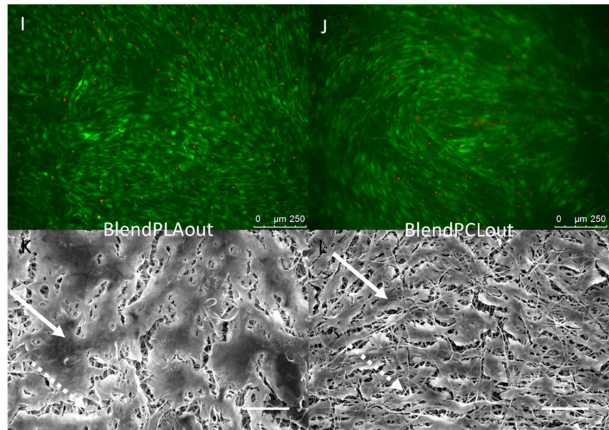
Figure 4. Fluorescence microscopy ( A , B , E , F , I , J ) and SEM observations ( C , D , G , H , K , L ) of C3H10T1/2 cells cultured for 96 h on PCL60nm ( A , C ), PCL1000nm ( B , D ), PLA ( E , G ), PCLaligned ( F , H ), BlendPLAout ( I , K ) and BlendPCLout ( J , L ) electrospun scaffolds. Fluorescence: Living cells (Calcein AM, green) and dead cell nuclei (EthD-1, red), scale bars 250 µ m. SEM: scale bars 100 µ m. Solid arrows: continuous cell tissue. Dashed arrows: fibers network visible due to cracks in the cell tissue or to a lower cell density.